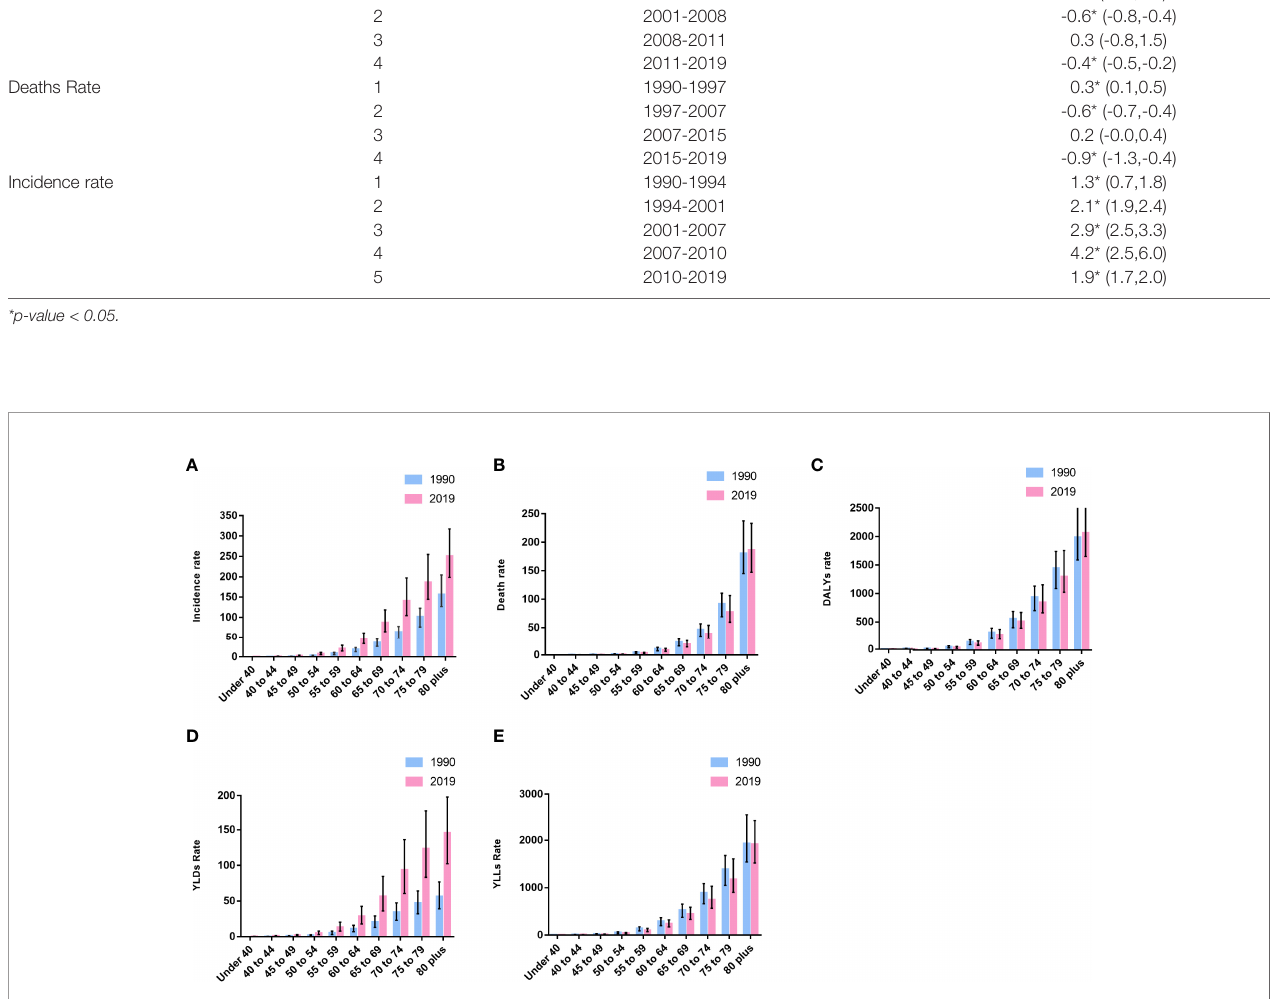
FIGURE 2 | Incidence (A) , death (B) , DALYs (C) , YLDs (D) , and YLLs (E) rate by age for prostate cancer in China in 2019.